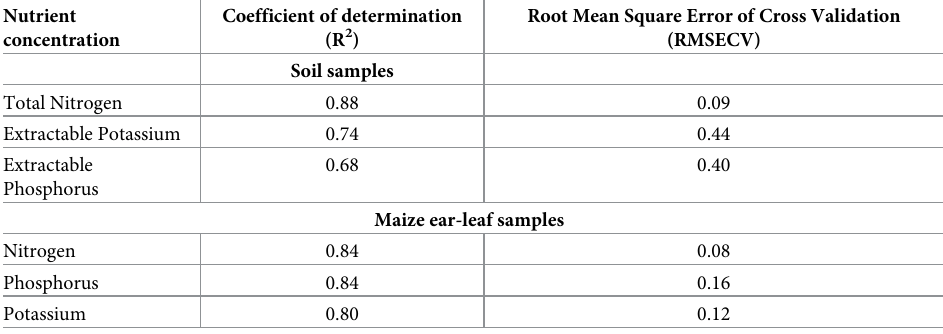
Table 2. Mid-infrared calibration model statistics that predicted soil and plant nutrient concentrations of the study